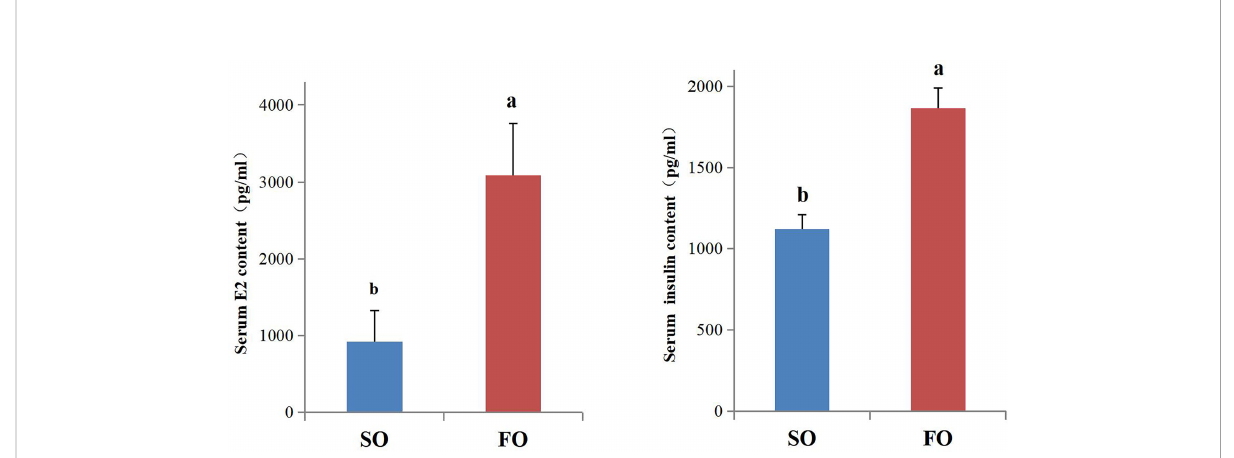
FIGURE 6 Serum E2 and insulin content of the female adult spotted scat fed with different oil sources. Data are presented as means ± SE. (n = 10). Different letters denote statistically signi fi cant differences ( P < 0.05), analyzed using T-test for independent